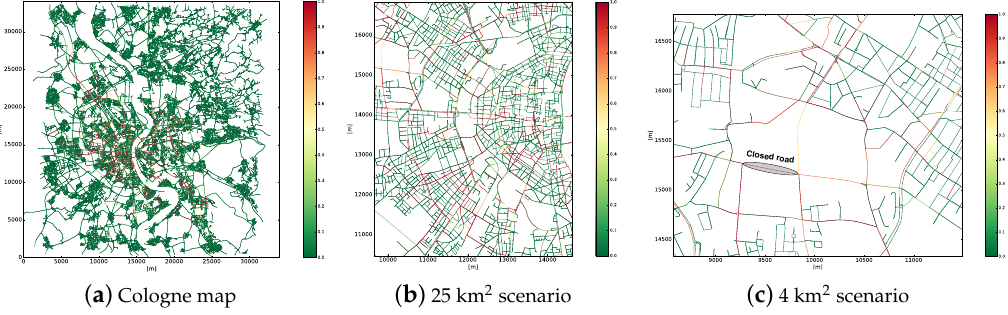
Figure 3. Cologne scenario with its roads colored by traffic condition classified by I am not interested in it (IAN3I) in the rush